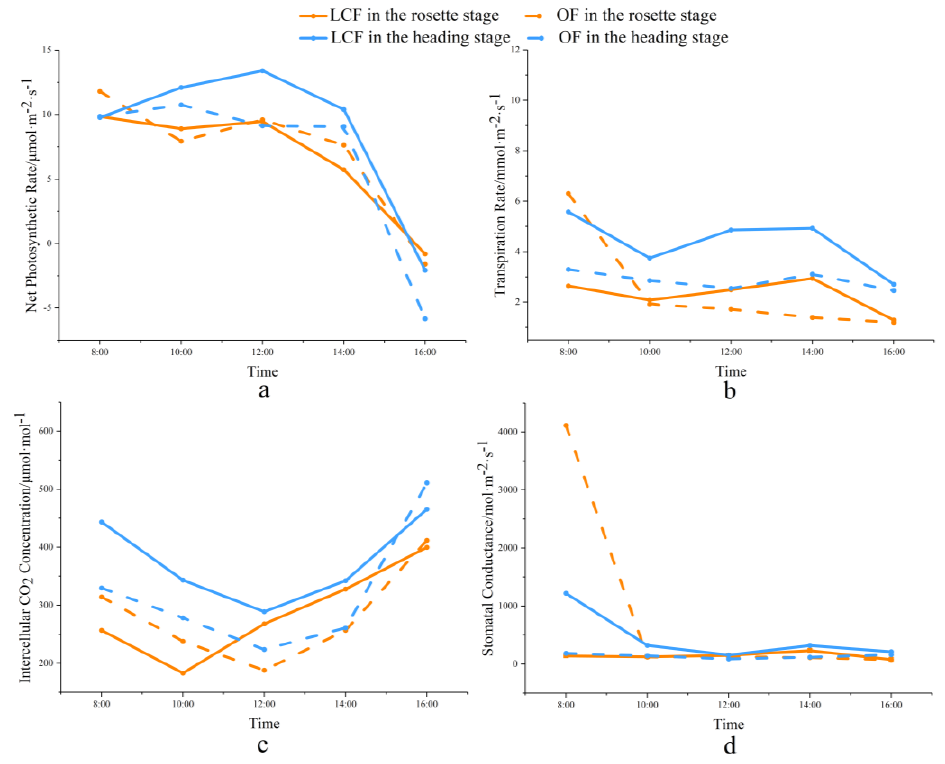
Figure 11. Effects of light conversion films (LCF) and ordinary film (OF) on ( a ) net photosynthesis, ( b ) transpiration rate, ( c ) intercellular CO 2 concentration, and ( d ) stomatal conductance. Table 6. Effects of light conversion film (LCF) and ordinary film (OF) on Photosynthetic Character- istics of plant leaves at different growth stages.